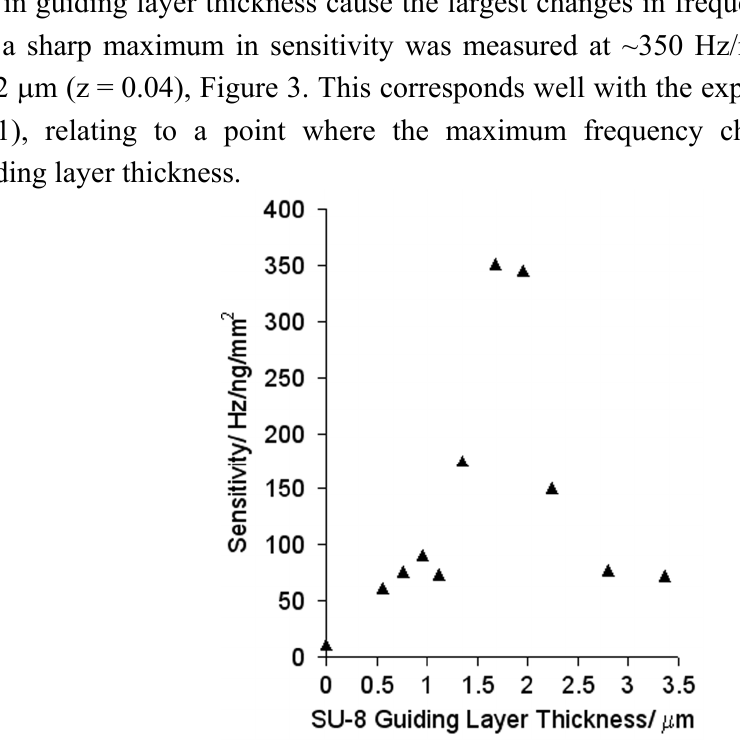
Figure 3 . Frequency sensitivity of Love wave